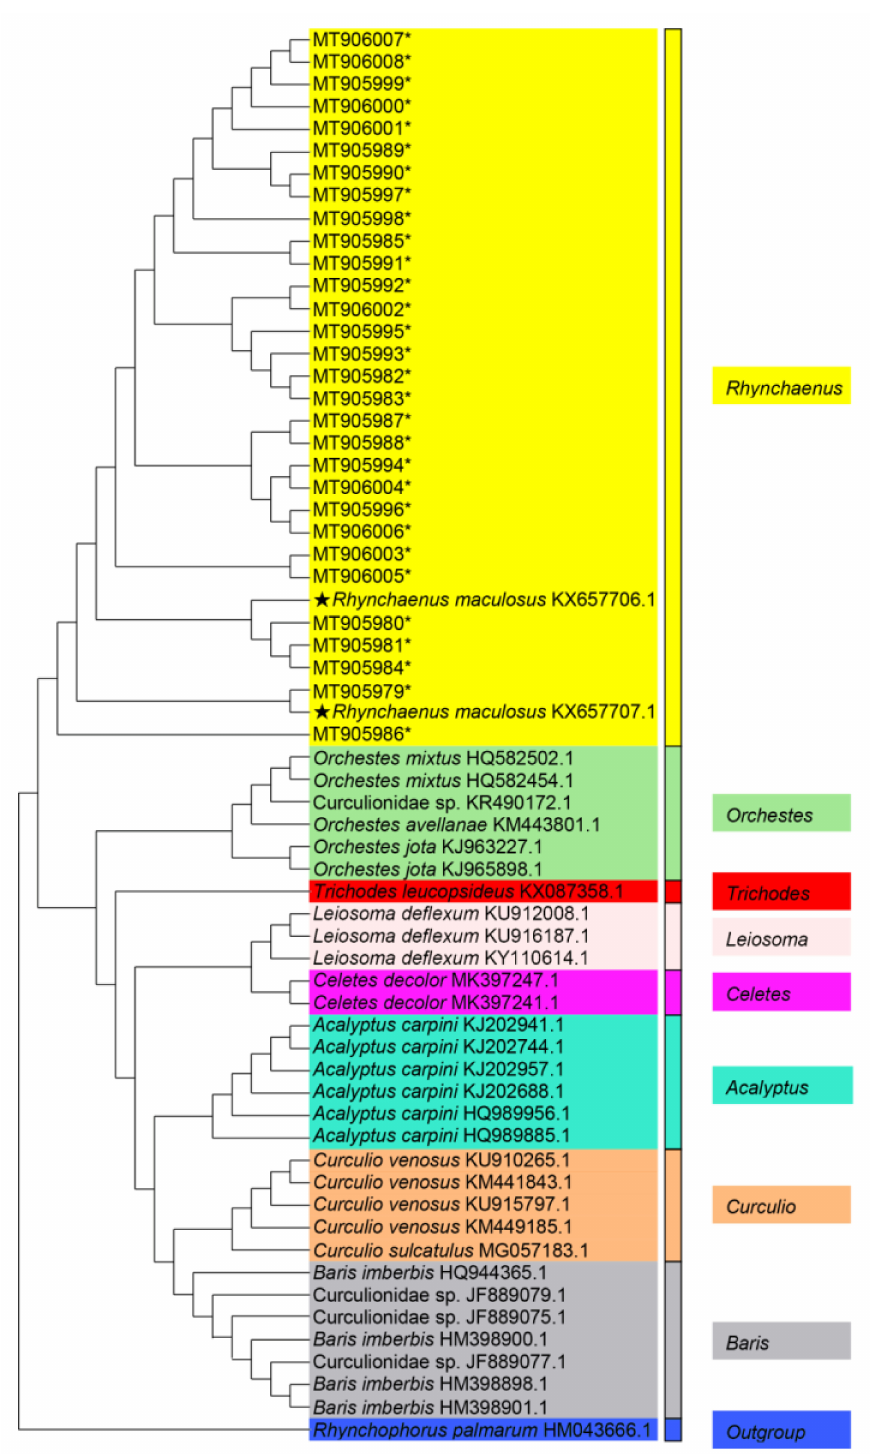
Figure 9. The neighbor-joining tree based on barcode sequences from specimens in the study and morphospecies in the GenBank database. * Specimens in the present study; (cid:70) morphospecies of Rhynchaenus maculosus already deposited in GenBank; color blocks indicate different